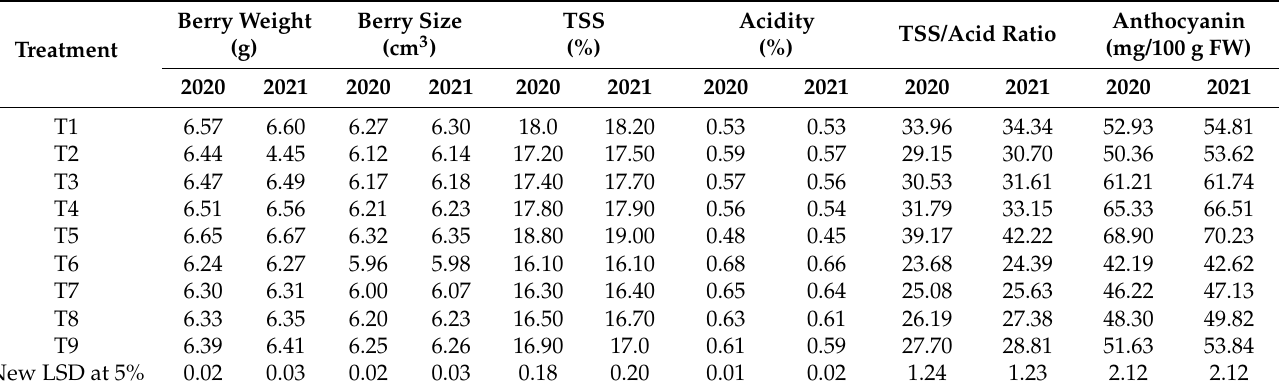
Table 5. Effect of mineral fertilizer individual or combined with superabsorbent polymers (SAPs) on physical and chemical characteristics of berries of Autumn Royal grapevines in 2020 and 2021